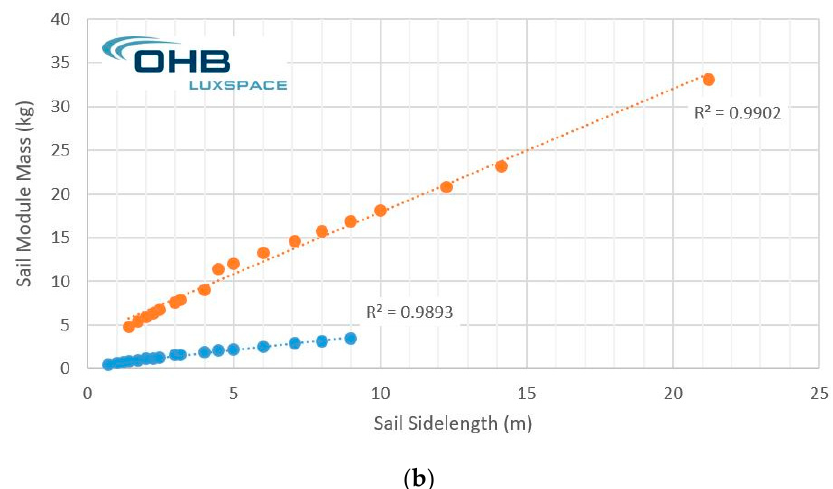
Figure 2. Typical configuration of square sail (module) deployed and tensed by four booms: ( a ) drawing of typical sail module showing at the center the booms mechanisms and the sail containers from which the sail segments are deployed, forming ultimately a flat square of sidelength “S”; ( b ) current and near-term sail module masses for two booms technologies behave almost linearly with respect to sail sidelength “S” [4].